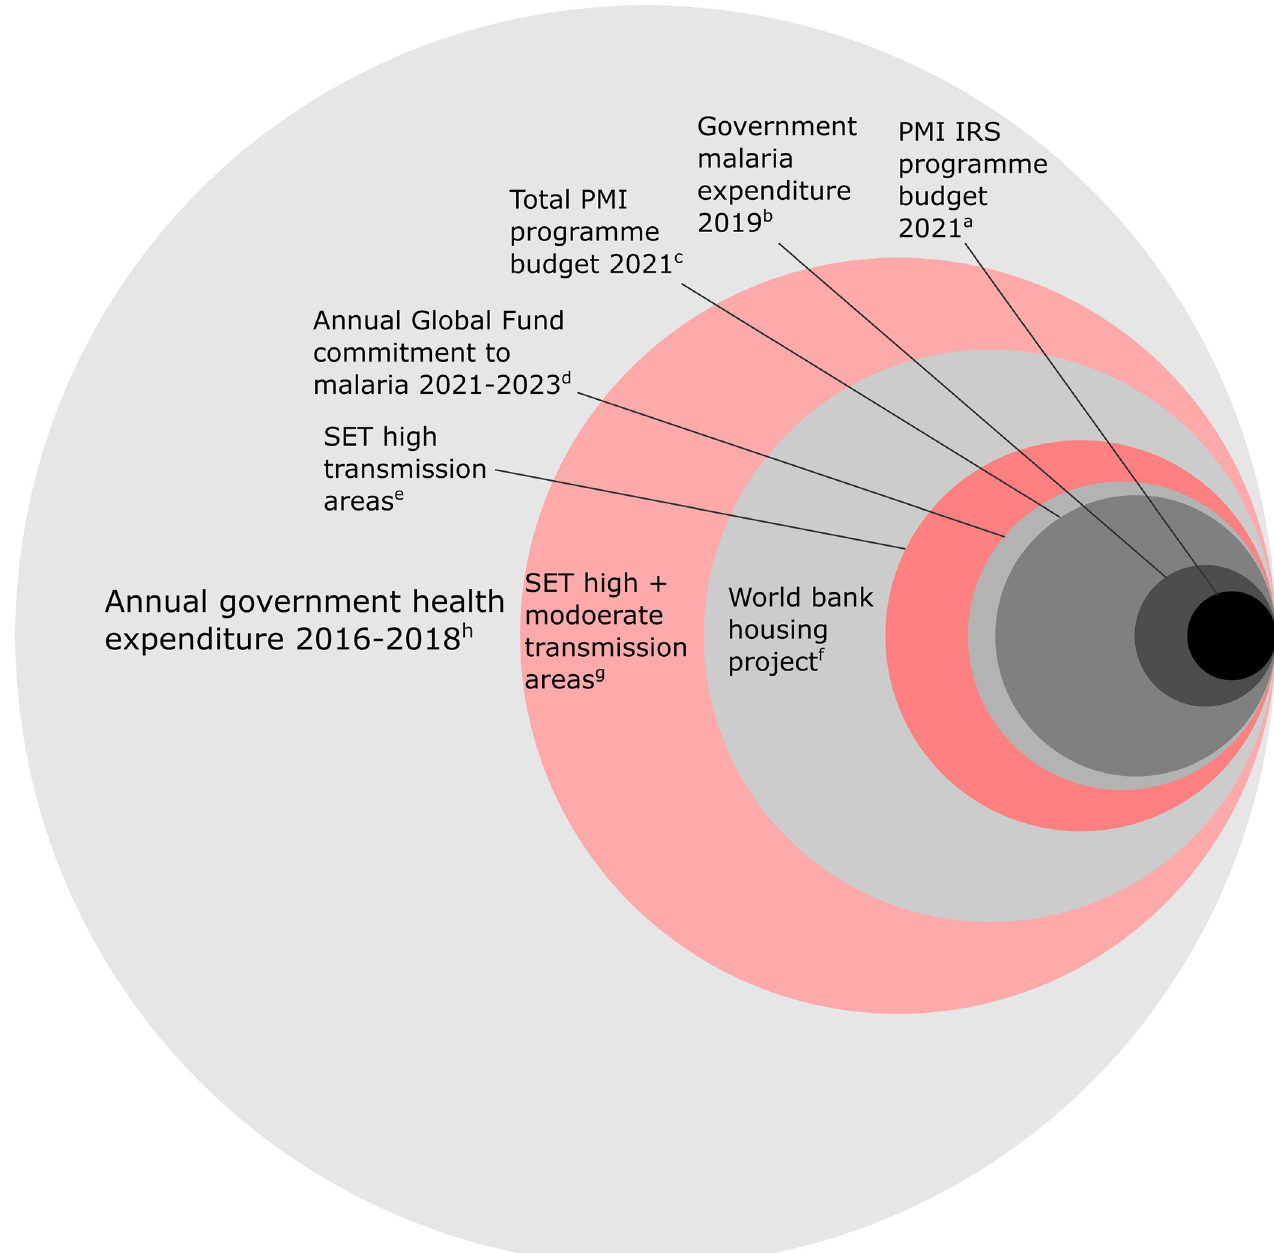
Fig 6. Comparison between estimated cost of SET in high and/or moderate malaria transmission areas of Coˆte d’Ivoire with example budgets. a US Government Presidents Malaria Initiative, planned obligation (budget) for Indoor Residual Spraying in Cote d’Ivoire for financial year 2021 ($2.4 M) [30]; b Domestic government malaria control expenditure, Cote d’Ivoire (2019) ($6 M) [31]; c US Government Presidents Malaria Initiative, planned obligation (budget) for all Malaria activities in Cote d’Ivoire for financial year 2021 ($24 M) [30]; d Global Fund Scaling up of interventions to combat malaria in Coˆte d’Ivoire grant phase 3 award (2021 to 2023), total commitment amount divided by three $86.756.101/3 [32]; e Annual cost of SET in high transmission areas ($46 M); f International Finance Corporation, World Bank group providing $100m investment to support construction and commercialisation of affordable housing in Coˆte d’Ivoire [33]; g Annual cost of SET in moderate + high transmission areas ($174 M); h Average annual domestic government health expenditure, Cote d’Ivoire MoH 2016–2018 ($ 484 M)